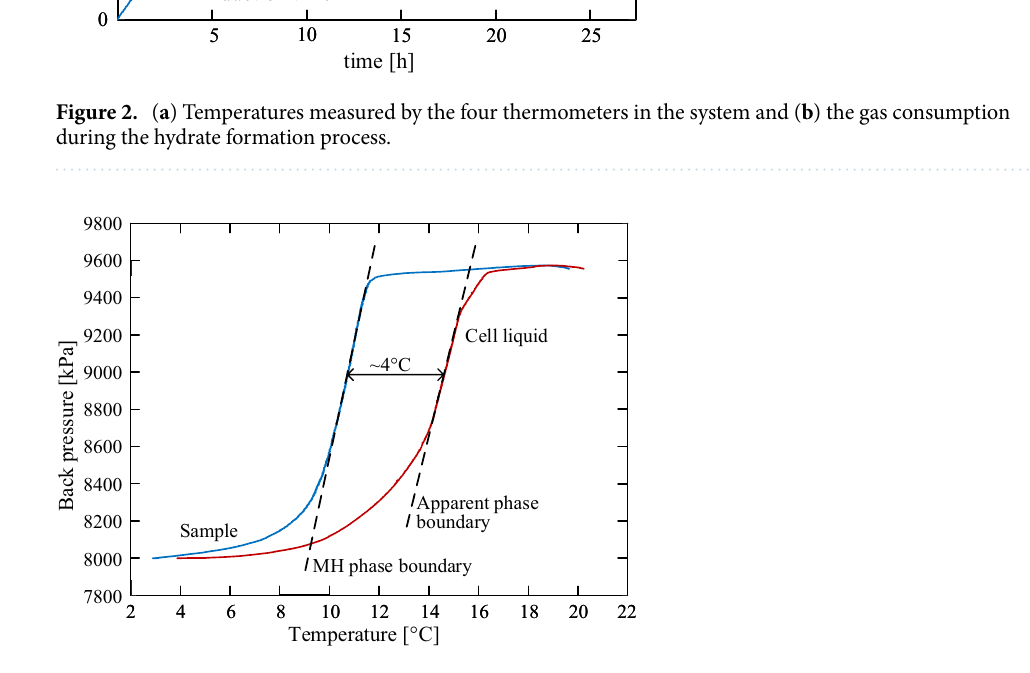
Figure 3. The thermodynamic response during the process of undrained thermal